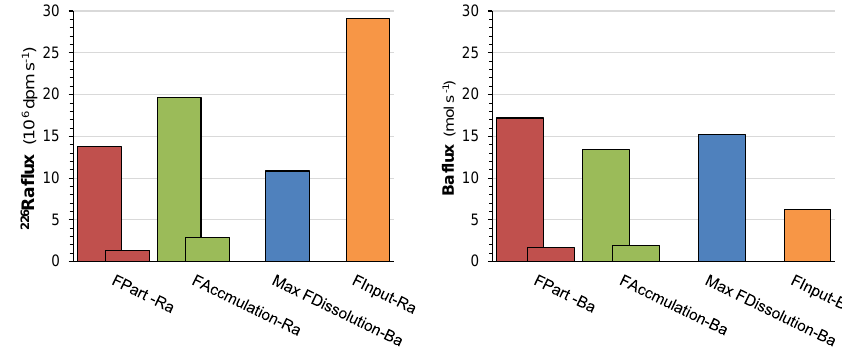
Figure 10. 226 Ra and Ba flux estimations: F Part- x is the particulate flux entering the box, F Accumulation- x is the sediment accumulation flux and F Dissolution- x is the flux of particle dissolution assuming that all the settling particles dissolve. x is either 226 Ra or Ba. Both maximum and minimum values are shown for F Part- x and F Accumulation- x . Max F Dissolution- x represents a maximum value since it is calculated by subtracting the minimum value of F Accumulation- x from the maximum value of F Part- x . F Dissolution- x is thus between zero (if all F part- x accumulates in the sediment) and this latter